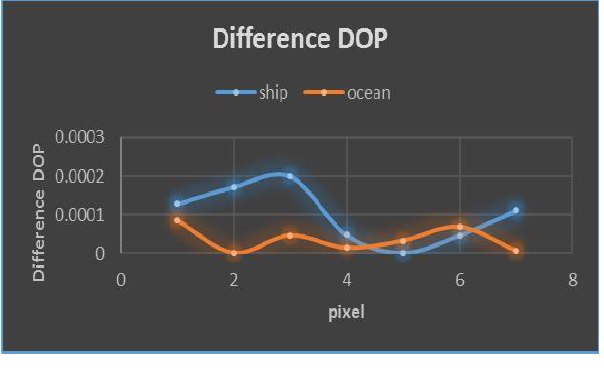
Fig. 7 ALOS1 Ship and ocean pixels [Difference of DOP] analysis